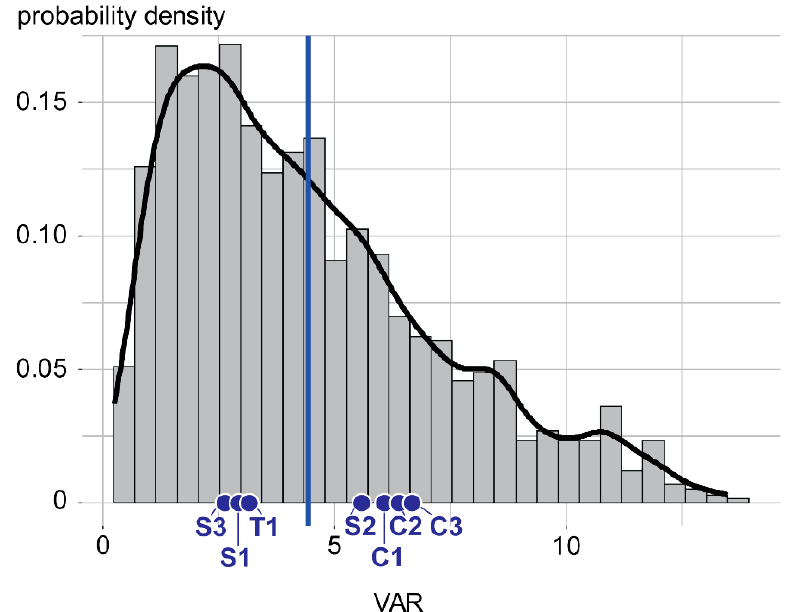
Figure 11. Probability distribution of VAR dataset. Blue line marks the dataset mean, and blue dots mark the case study values (codes explained in Figures 5 and 6).